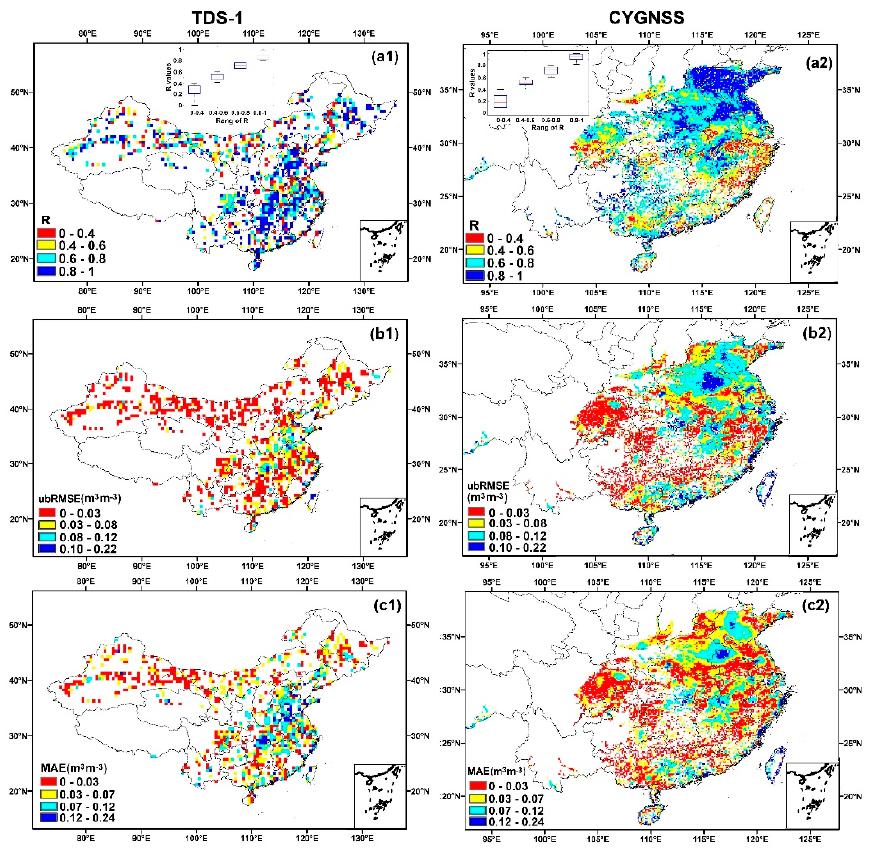
Figure 8. Statistical indices for the SM derived from TDS-1 / CYGNSS against the SMAP SM. ( a 1– a 2) R, ( b 1– b 2) ubRMSE, and ( c 1– c 2) MAE.